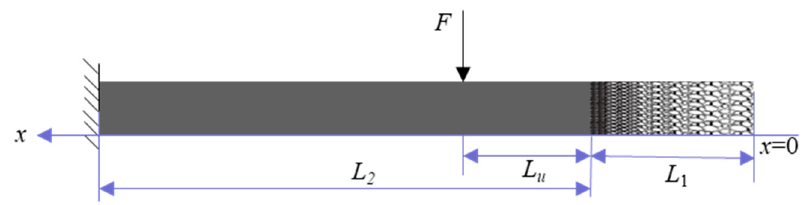
Figure 1. A uniform beam with functionally graded porous (FGP) end.